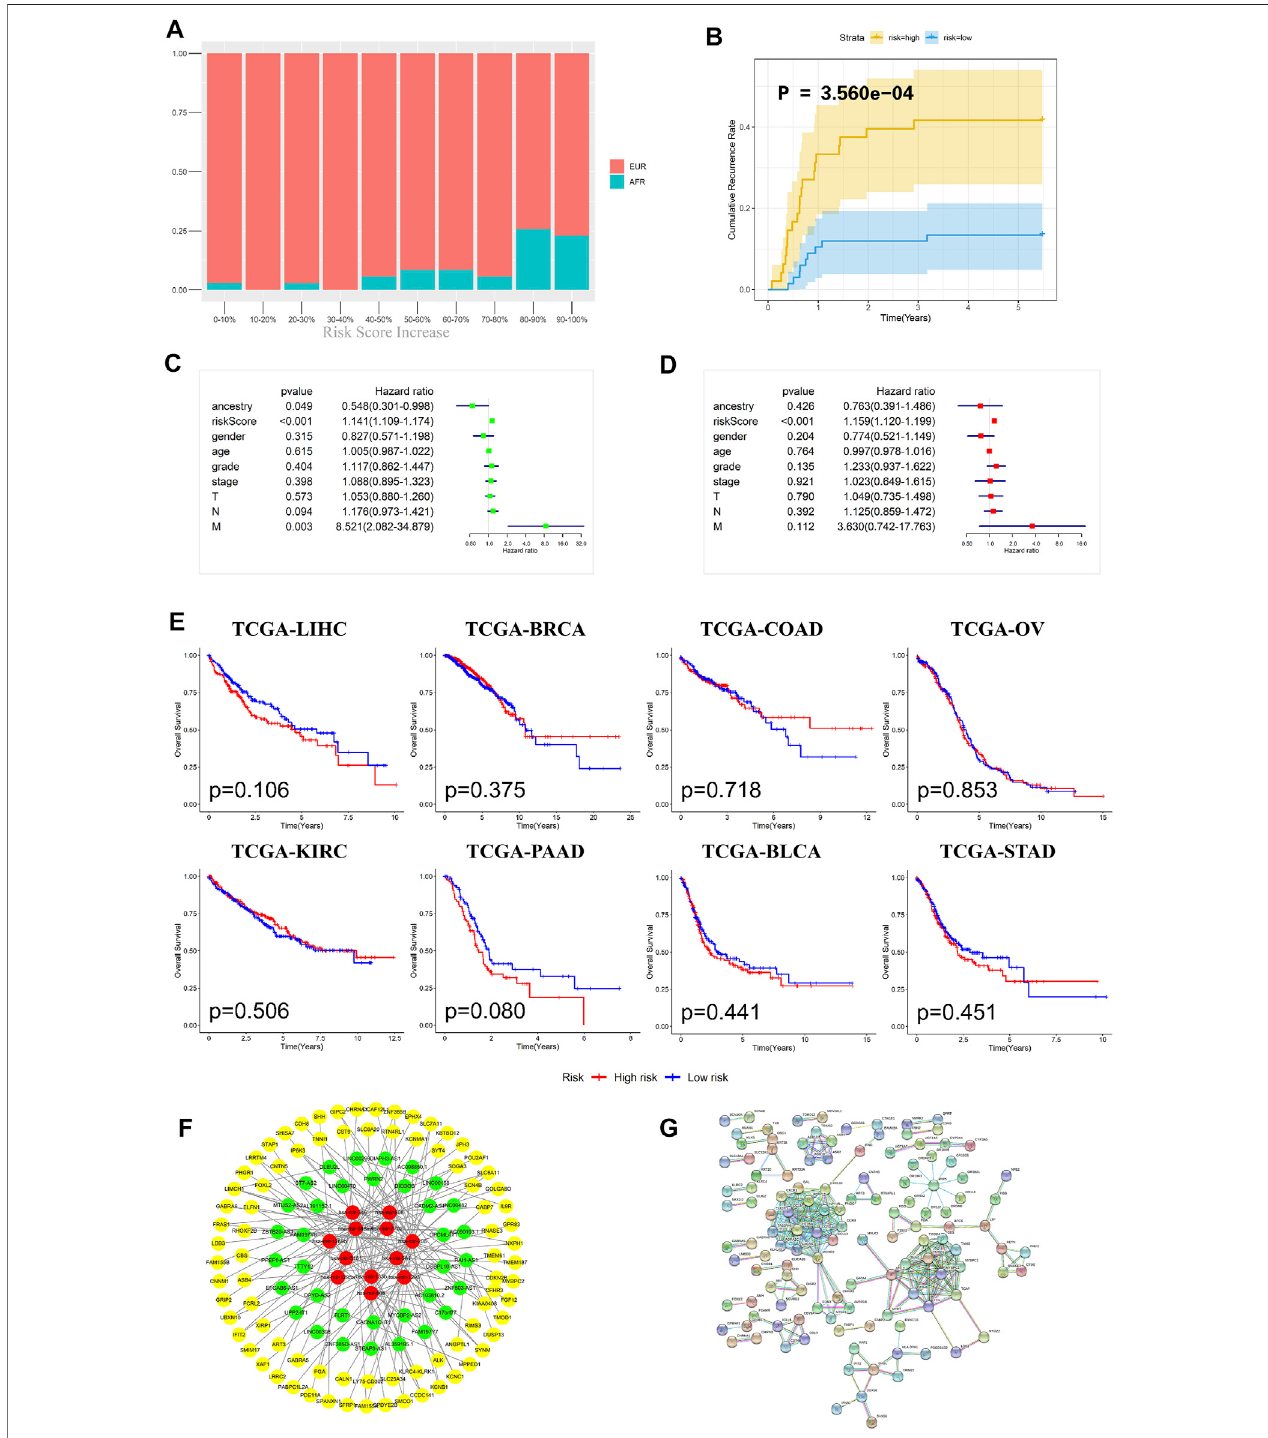
FIGURE 6 | Evaluation effectiveness and speci fi city of the ceRNA risk regression model. (A) The percentages of EUR and AFR OSCC patients in different risk strati fi cation groups. (B) IntheceRNA riskregressionmodel, therelapse rateoftheOSCCpatientsinthehigh-risk groupwassigni fi cantlyhigher than thatinthelow-risk group. (C) Univariate Cox analysis of the ceRNA risk regression model and related clinical information such as genetic ancestry. (D) Multivariate Cox analysis of the ceRNAriskregressionmodelandrelatedclinicalinformationsuchasgeneticancestry. (E) Nosigni fi cantdifferenceintheprognosesofallcancerpatientswasfound whenusingtheceRNAriskregressionmodel. (F) TheceRNAnetworkofdifferentiallyexpressed RNAs betweenEURand AFRancestries. (G) Theinteractionnetworkof differentially expressed proteins between the EUR and AFR ancestries.